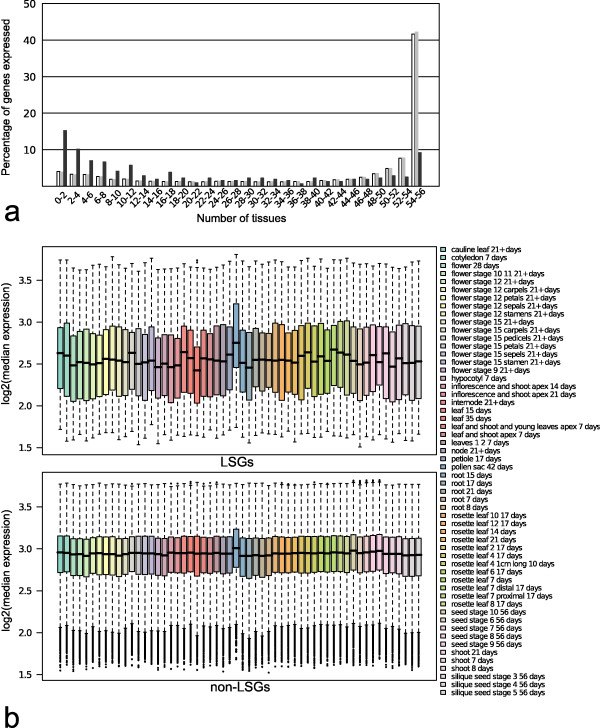
Tissue expression patterns in LSGs and non-LSGs. a) Distribution of the number of tissues/developmental-stage each gene called as present (expressed) in the AtGenExpress developmental series microarray experiment (see methods). White bars represent all representative gene models tested. Light gray bars represent non-LSGs. Dark gray bars represent LSGs. b) Distribution of log2 median expression of genes called as present for each tissue/developmental stage in the AtGenExpress developmental series microarray experiment.